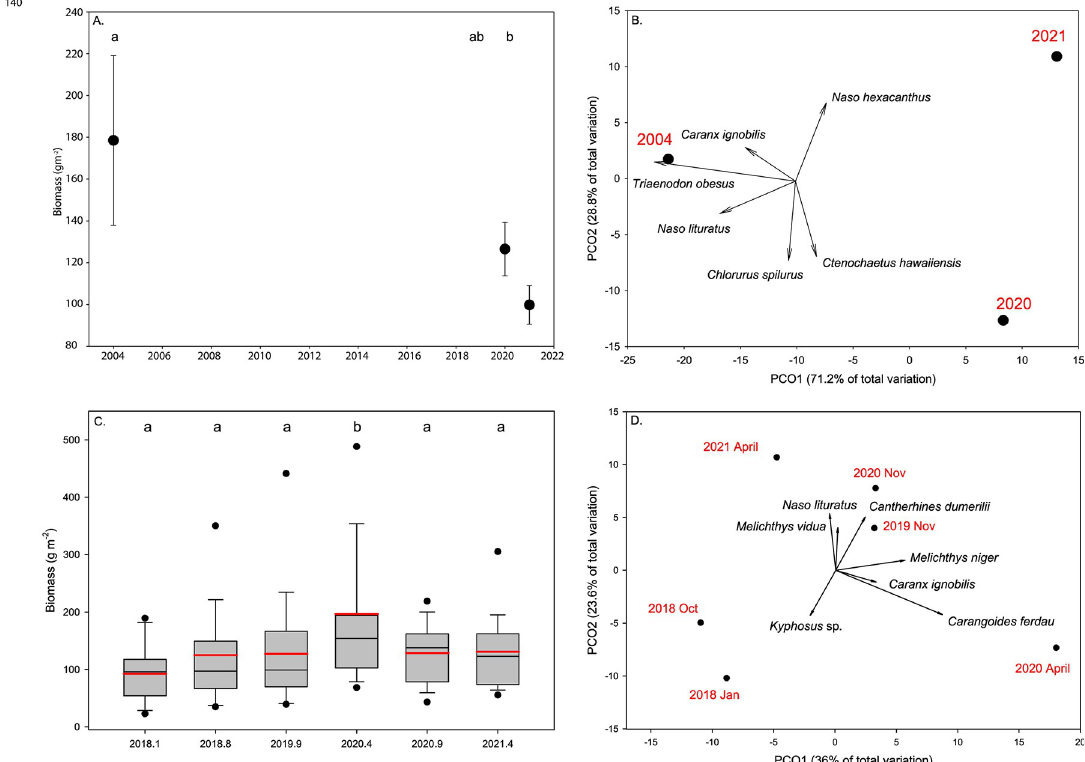
Fig 3. Changes in the fish community at Molokini. Comparisons of fish biomass at all trophic levels among sampling periods from (A) long-term surveys and (C) DAR surveys. Box plots showing median (black line), mean (red line), upper and lower quartiles, and 5th and 95th percentiles. Principal coordinates analysis of fish assemblage composition based on biomass (g m -2 ) by sampling period for (B) long-term surveys and (D) DAR surveys. Data were ln(x+1)-transformed prior to analyses. Vectors are the relative contribution and direction of influence of fish taxa to the observed variation among sampling periods (Pearson Product movement >